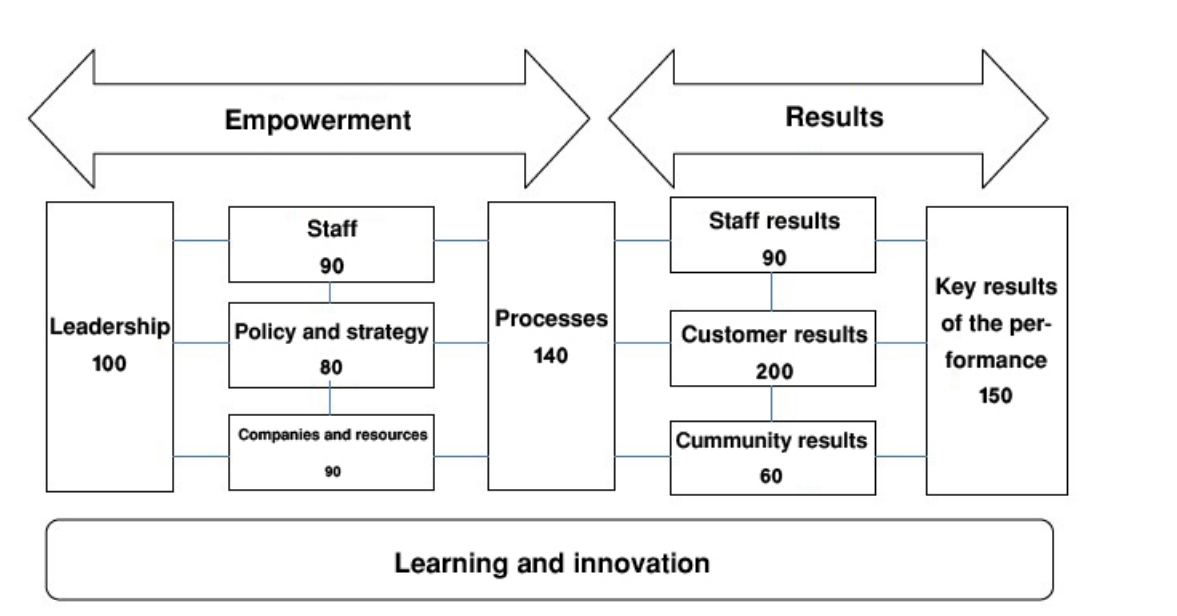
Figure 3. The Block Diagram of European Foundation for Quality Management (EFQM) [32]